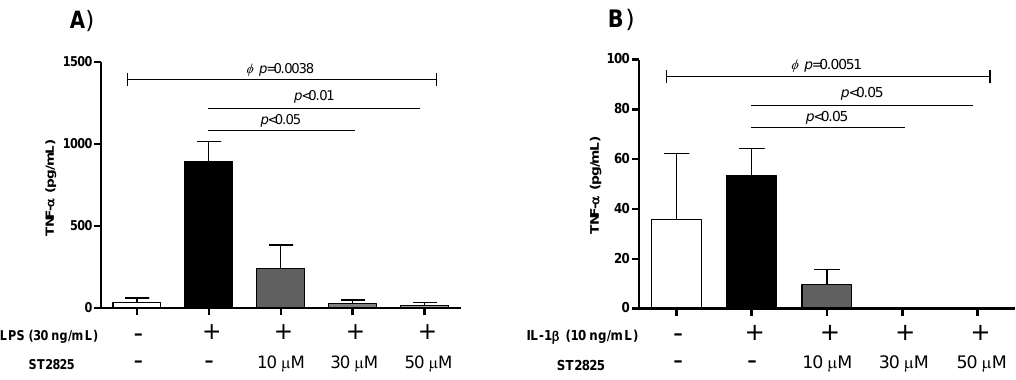
Figure 1. Inhibition curve for LPS and rhIL-1β mediated by ST2825 molecule. ( A ) The soluble levels of TNF-α in the supernatant of LPS-stimulated peripheral blood mononuclear cells (PBMC) at 30 ng/mL and LPS (30 ng/mL) plus different concentrations of ST2825 (10, 30 and 50 μM) were determined. ( B ) The soluble levels of TNF-α in the supernatant of rhIL-1β-stimulated PBMC at 10 ng/mL and rhIL-1β (10 ng/mL) plus different concentrations of ST2825 (10, 30 and 50 μM) were determined. Significant inhibition was identified at 30 μM ( p < 0.05) and 50 μM ( p < 0.01) of ST2825 for LPS; while for rhIL-1β significant inhibition was identified at 30 μM ( p < 0.05) and 50 μM ( p < 0.05) of ST2825. Data provided in medians and interquartile ranges (n = 4), Φ Kruskal-Wallis test was performed, and Dunn’s test obtained statistically significant differences.